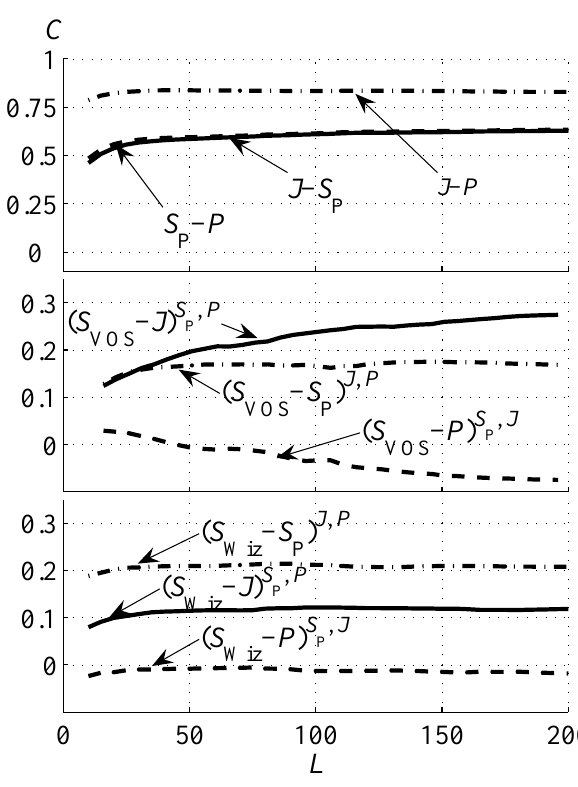
Fig. 7. Upper panel: the correlations between J and S P (solid), J and P (dash-dot), and P and S P (dashed). Other two panels show the correlations of S VOS (middle) and S Bz (bottom) with J (solid), S P (dash-dot), and P (dash) pure components (orthogonal to the pa- rameters given in the upper indexes). S P and P for the correlations with S VOS (middle panel) are recalculated to the dayside magne-